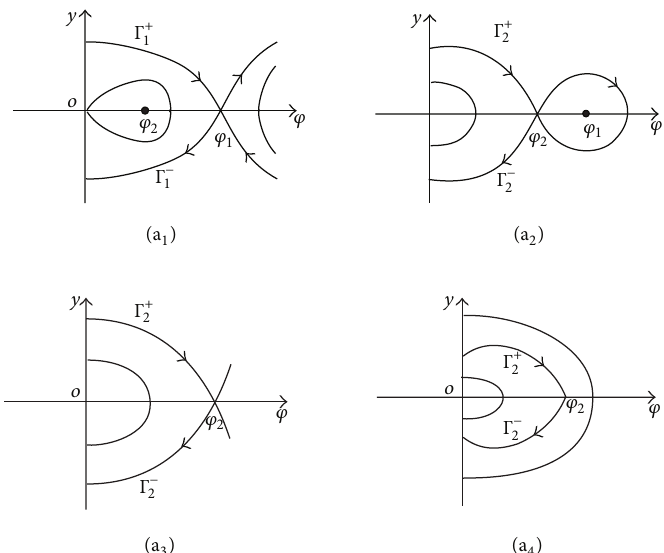
Figure 3: The graphs of orbits Γ ± 1 and Γ ± 2 when (a 1 ) 𝛿 > 0 and (𝑎,𝑏) ∈ 𝐴 2 , (a 2 ) 𝛿 < 0 and (𝑎, 𝑏) ∈ 𝐴 2 or 𝐴 3 or 𝑙 2 , (a 3 ) 𝛿 < 0 and (𝑎,𝑏) ∈ 𝐴 1 or 𝐴 6 or 𝑙 1 (𝑎 > 0) , and (a 4 ) 𝛿 < 0 and (𝑎,𝑏) ∈ 𝑙 3 .